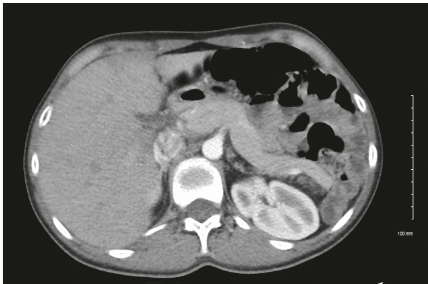
Figure 1: Axial view CT of the abdomen showing elongated pancreatic tail.